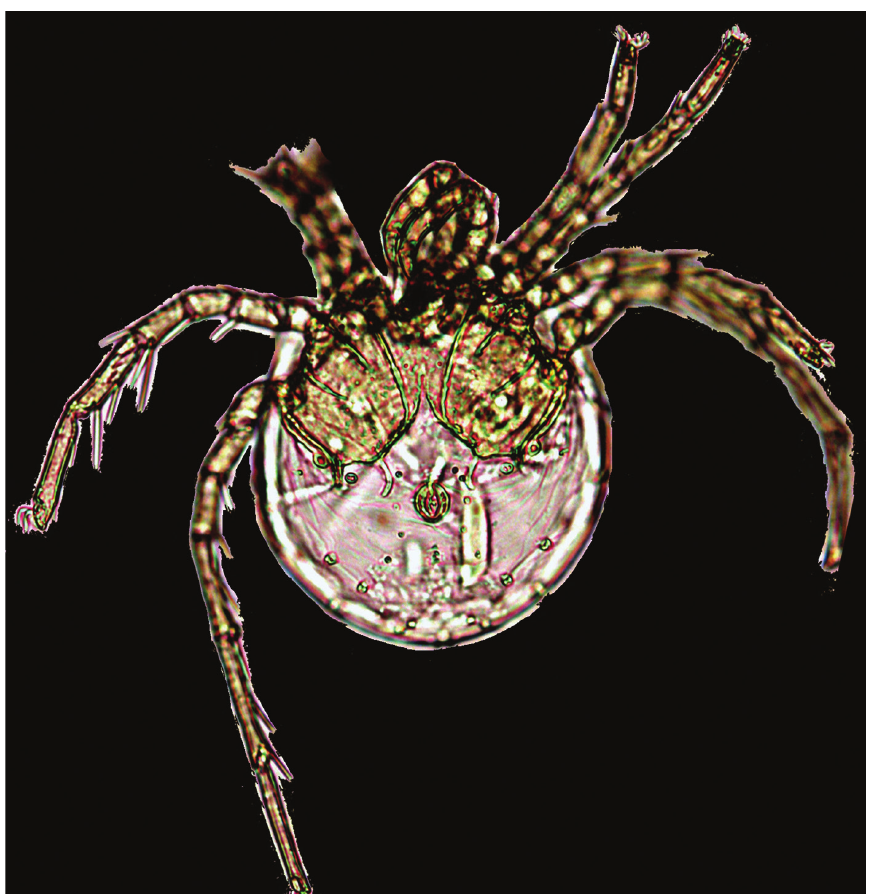
Figure 2. Photograph of Litarachna lopezae sp. n., male, Bajo de Sico: ventral